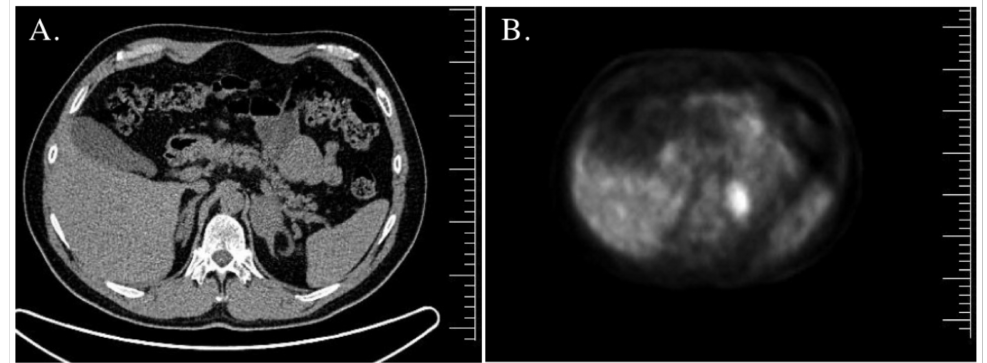
Figure 2. ( A ) Case 7—adrenal unenhanced computed tomography (CT) scan. The left adrenal tumor was 44 mm in size. ( B ) Case 7—Positron emitting tomography investigation using 18F-fluoro-2- deoxy-D-glucose combined with CT ( 18 FDG PET/CT) with a visualized increased uptake within the left adrenal